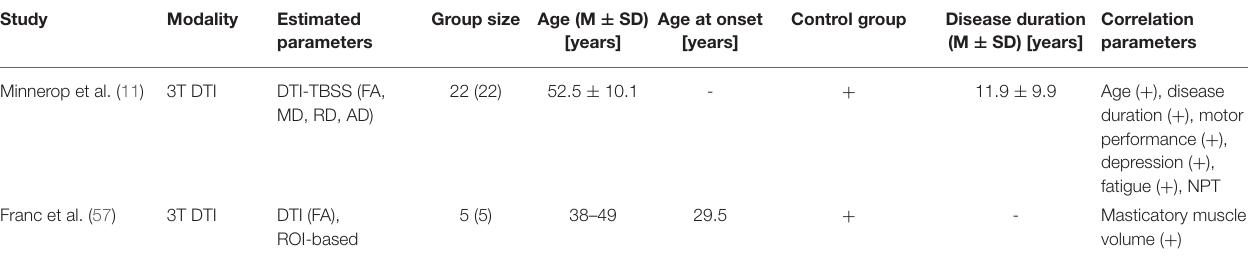
TABLE 7 | Quantification of white matter alterations in DM2.